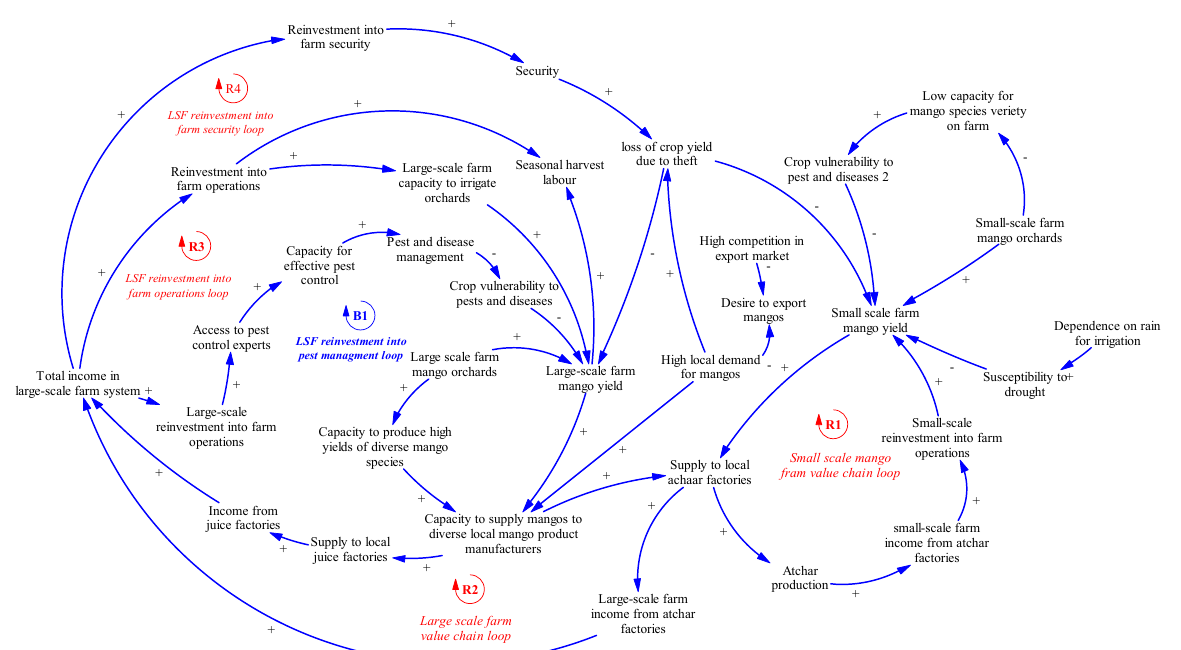
Figure 4. Causal loop diagram (CLD) showing mango farming systems in the Vhembe district, Limpopo. Arrows connect two or more variables of interest and are causal links that run in the stated direction. ‘+’ = a positive relationship, indicating that the causality runs in the same direction (i.e., an increase in variable A will cause an increase in variable B and vice versa); ‘ − ’ = a negative relationship, indicating that the causality runs in the opposite direction (i.e., an increase in variable A will cause a decrease in variable B and vice versa). The balancing feedback loops are numbered Bn and labelled in blue font. The reinforcing feedback loops are numbered Rn and labelled in red font. LSF refers to Large-scale farm/farming. Adapted with permission from Selebalo et al. [41] 2022. Itumeleng